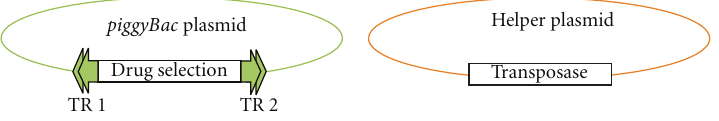
Figure 2: Basic plasmid designs for piggyBac mutagenesis in Plasmodium . The donor plasmid consists of a Plasmodium drug selection cassette flanked by the terminal repeats (TR) of piggyBac . The helper plasmid provides the piggyBac transposase, which mediates the trans- position event into the Plasmodium genome upon cotransfection with the donor